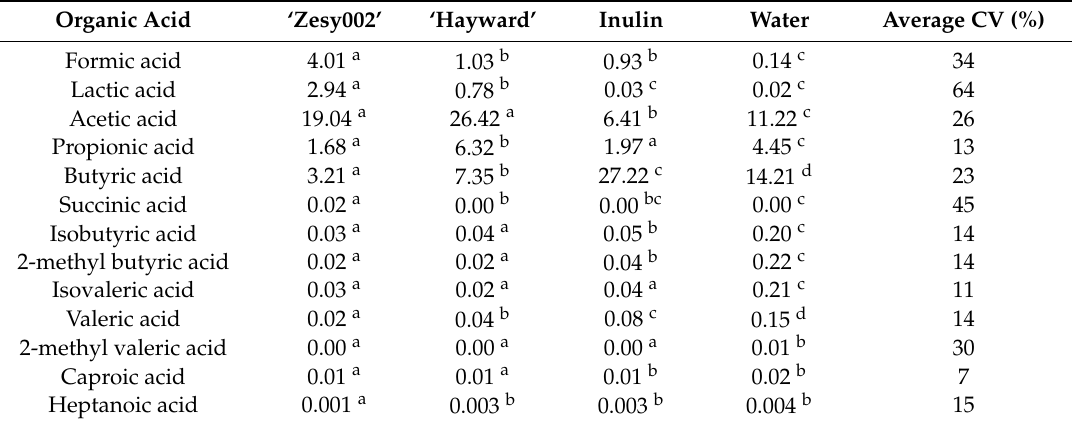
Table 1. Organic acid concentrations after 18 h of